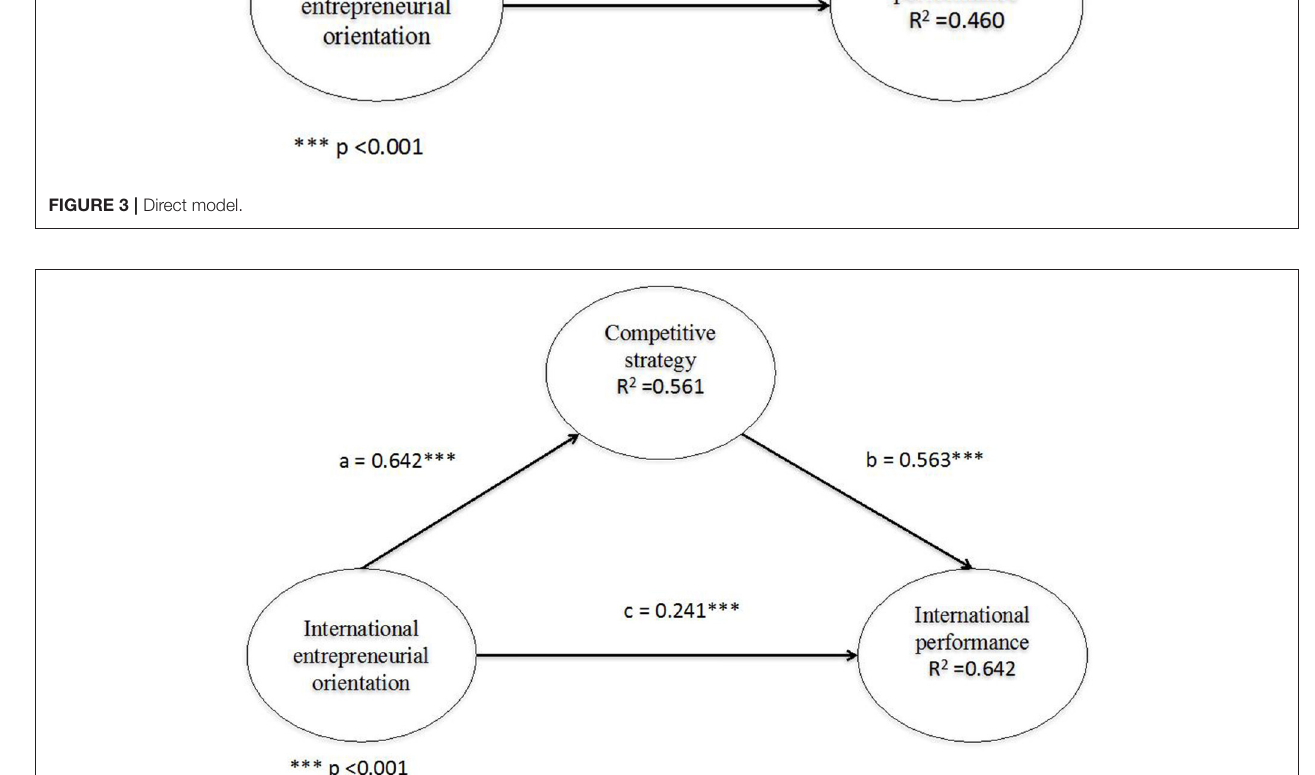
FIGURE 4 | Mediation